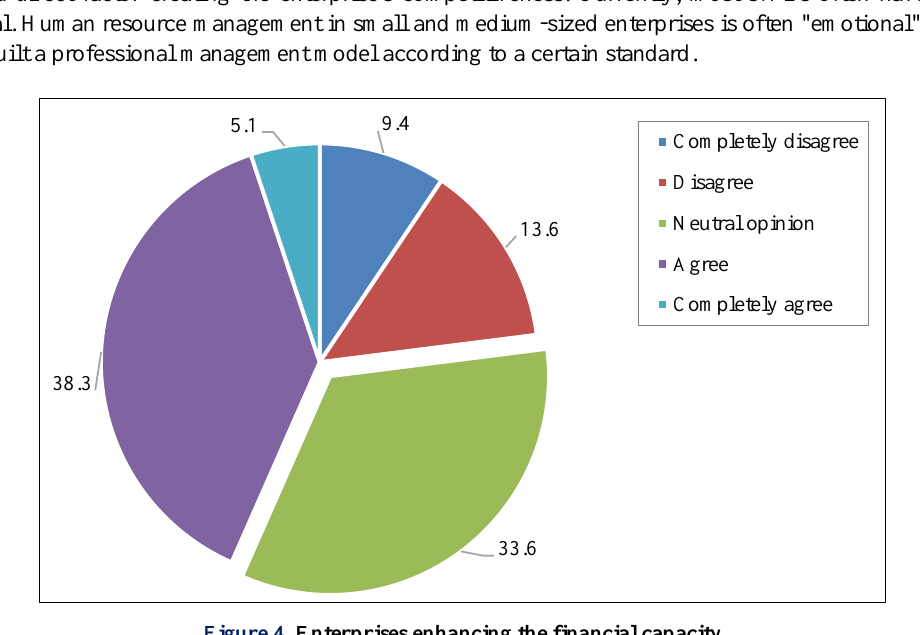
Figure 4. Enterprises enhancing the financial capacity